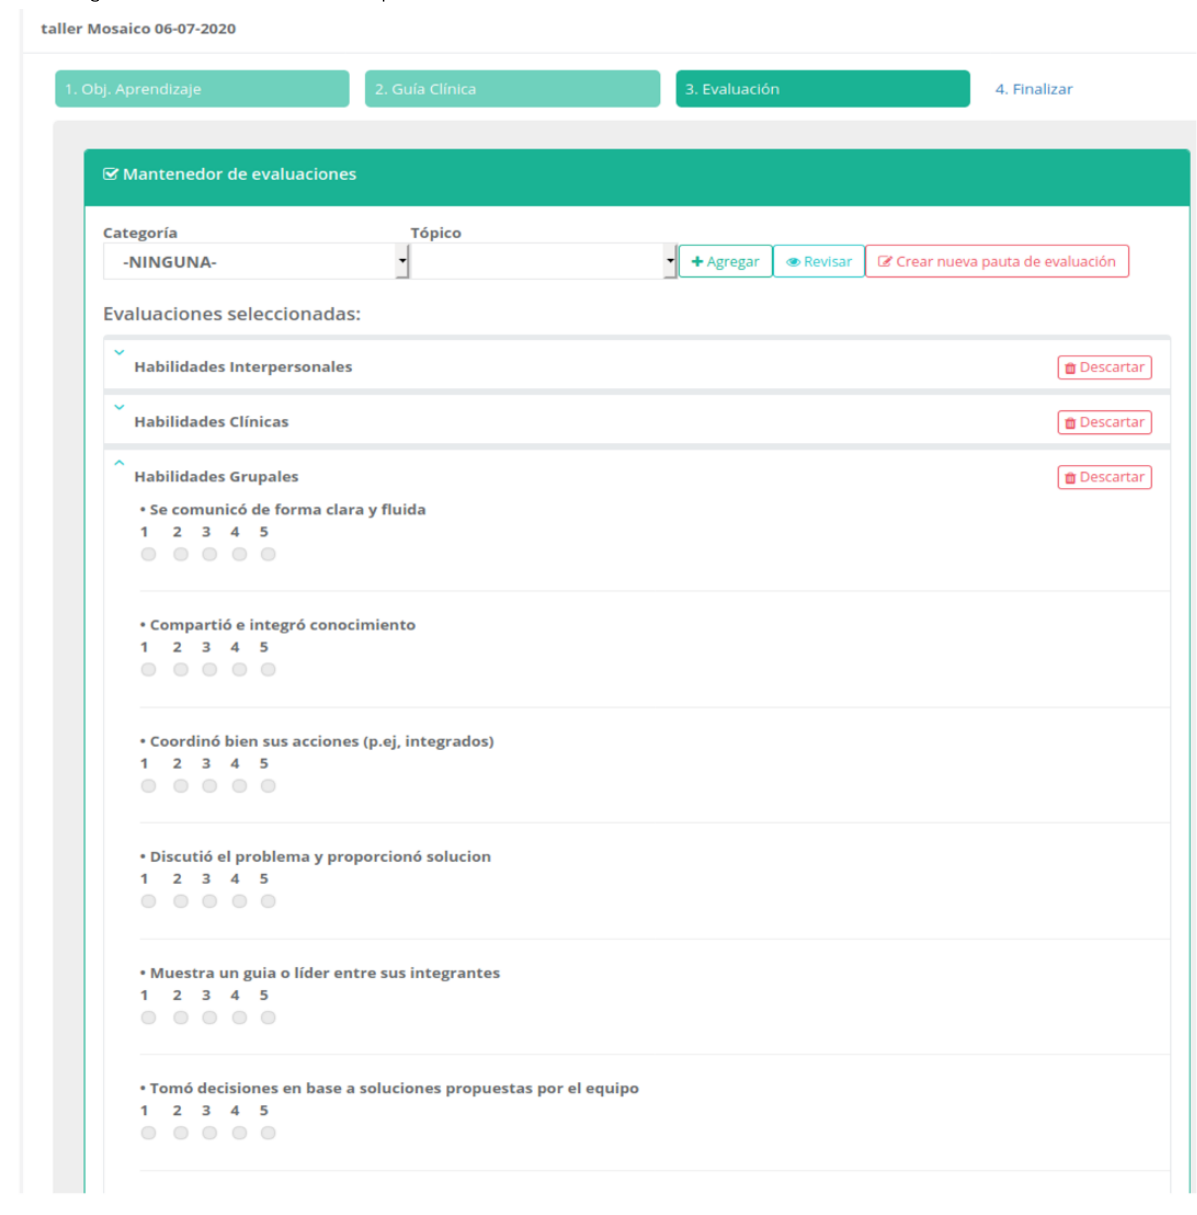
Figure 5. Design of the simulation session module. Once the request by the academic simulation unit is approved, the teacher can design the session with a clinical guide and rubric to assess the